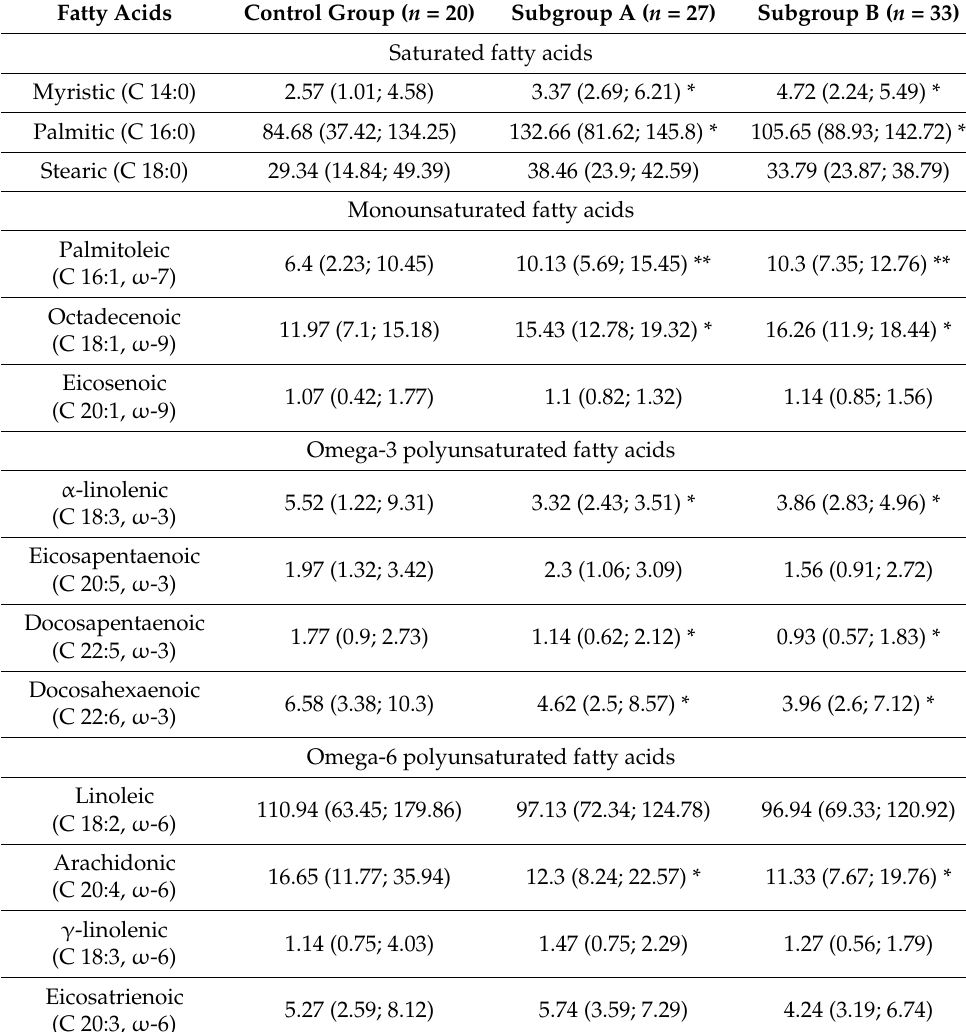
Table 3. The content of FAs in the blood of men in Subgroups and in the Control group, Me (25%; 75%),